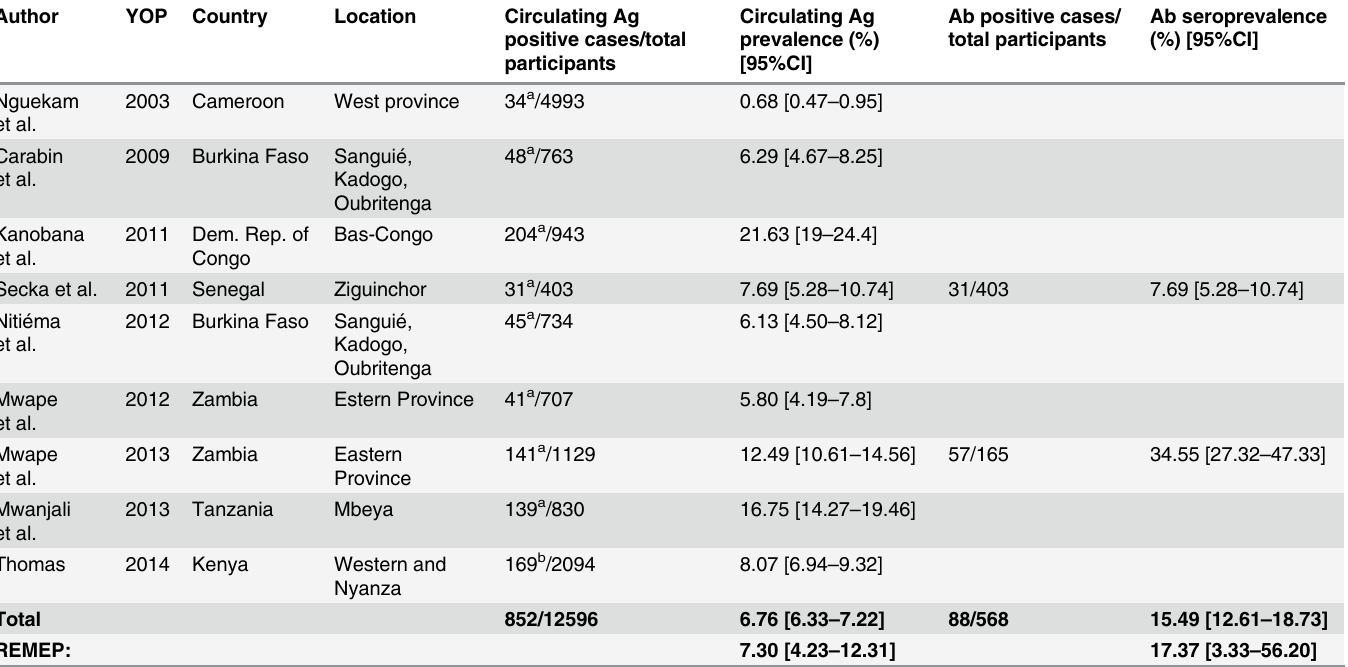
Table 1. Sero-epidemiological studies using Ag-ELISA and/or EITB for human cysticercosis in